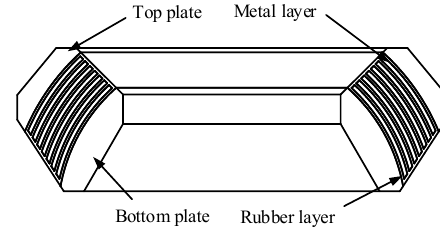
Figure 1. Typical flexible joint.